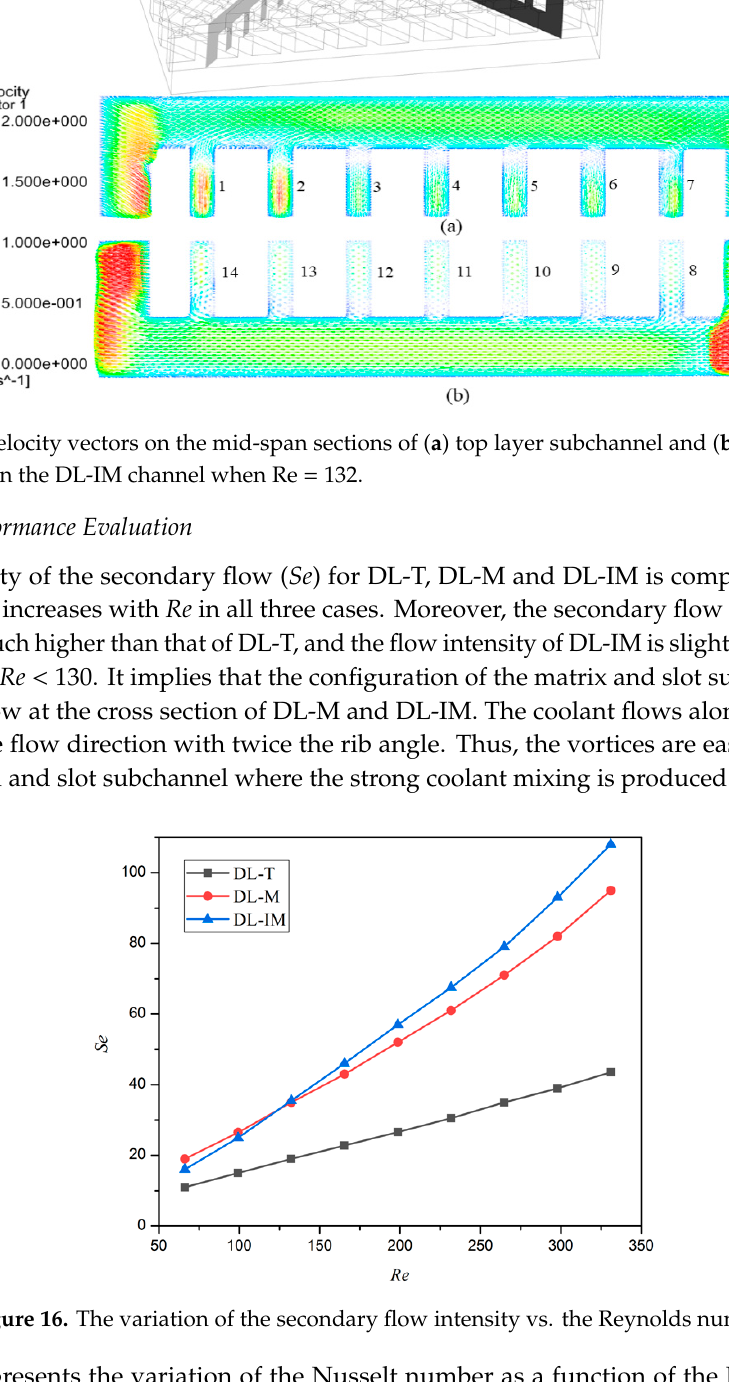
Figure 14. Streamlines at the intersections of subchannels and slot (Re=132).